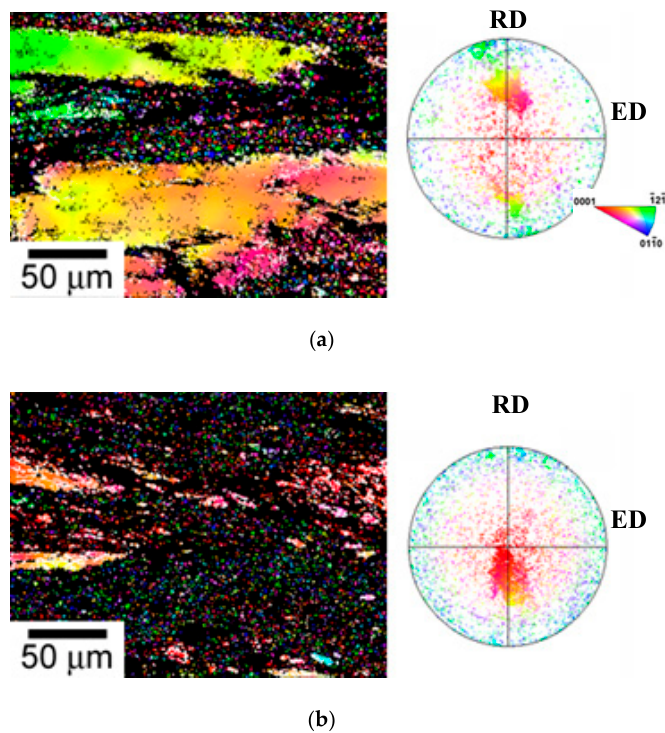
Figure 13. ( a ) Orientation Image Mapping and (0002) pole figure of the deformed samples at 300 °C of the extruded GWZ831 alloy after ( a ) 0 and ( b ) ECAP passes in the peak aged condition. The white arrow indicates the extrusion or ECAP direction.